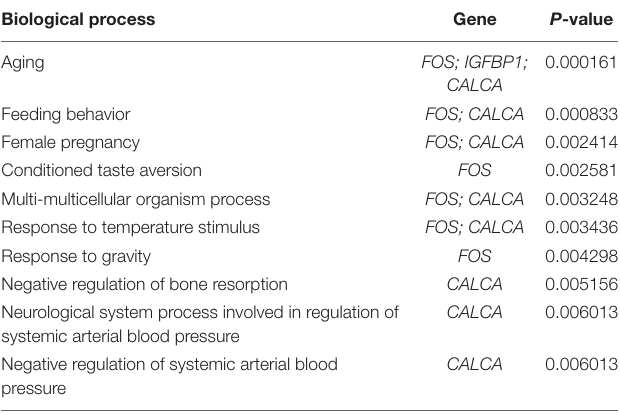
TABLE 1 | Gene ontology biological process enrichment results.